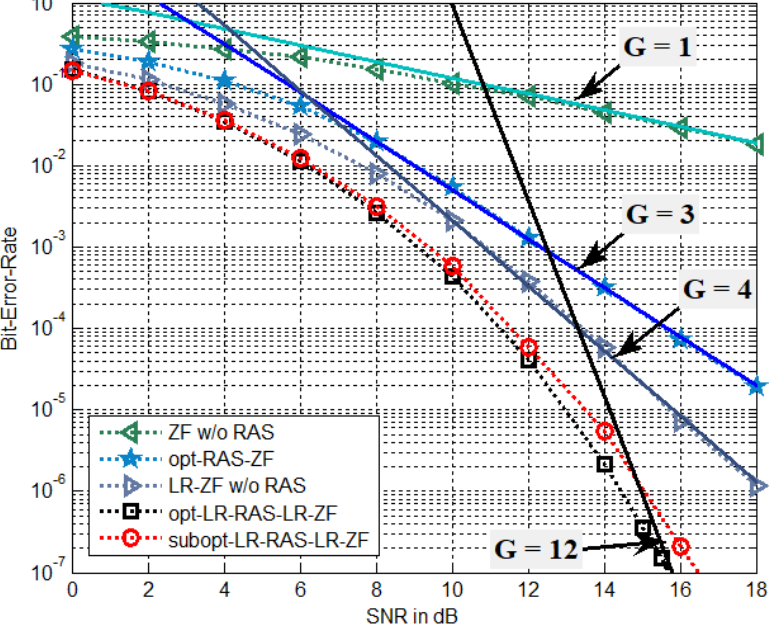
Figure 4. BER of the proposed algorithms for the LR-PSM system with N T = 4, N R = 6, and